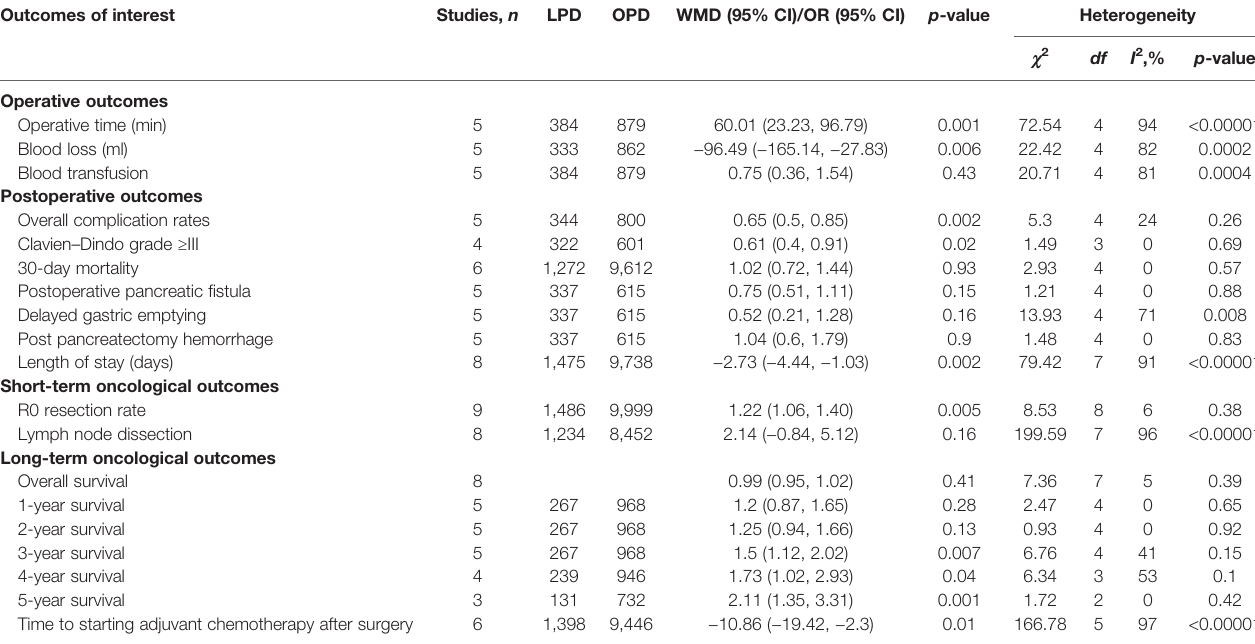
TABLE 2 | Summary results of the meta-analyses.